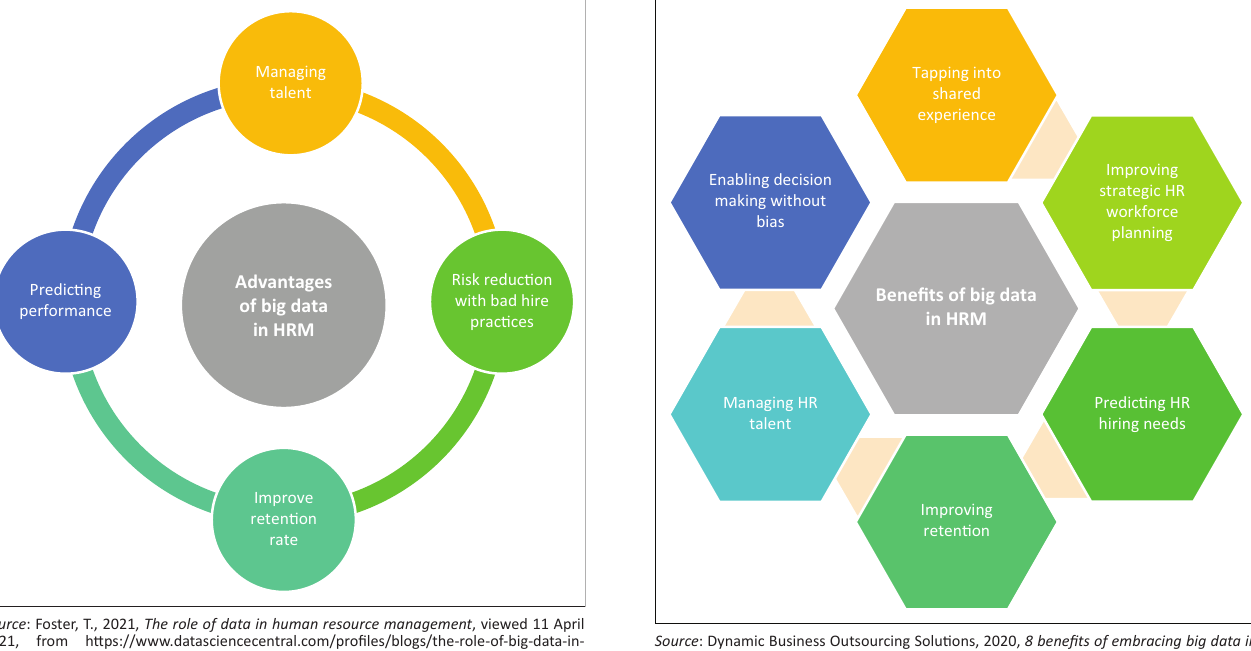
FIGURE 2: Advantages of big data in human resource management. FIGURE 3: Embracing big data.